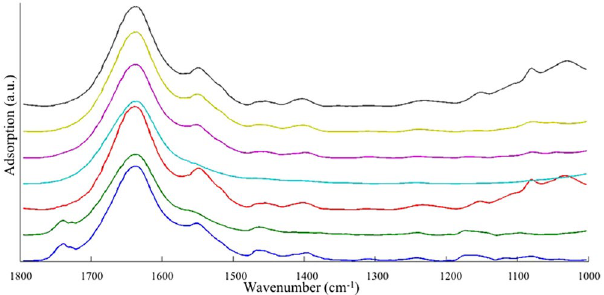
Figure 1. Averaged FT-IR spectra of each type of meat and offal samples. From the bottom to the top: beef meat, beef honey comb tripe, beef liver, beef omasum, pork heart, pork kidney and pork liver.